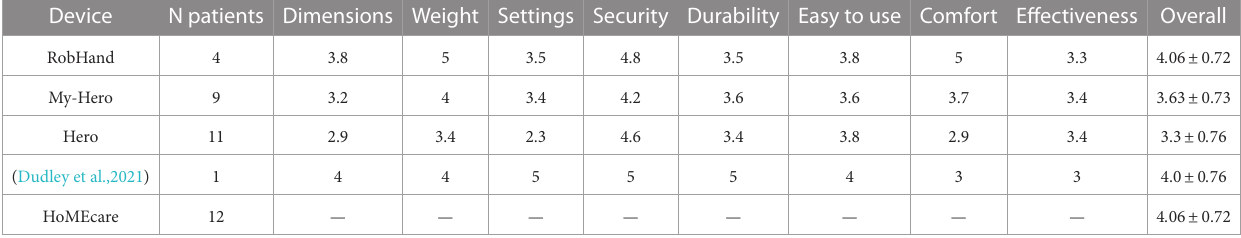
TABLE5 ComparisonoftheQUESTquestionnaireresultswithotherrelatedworks.